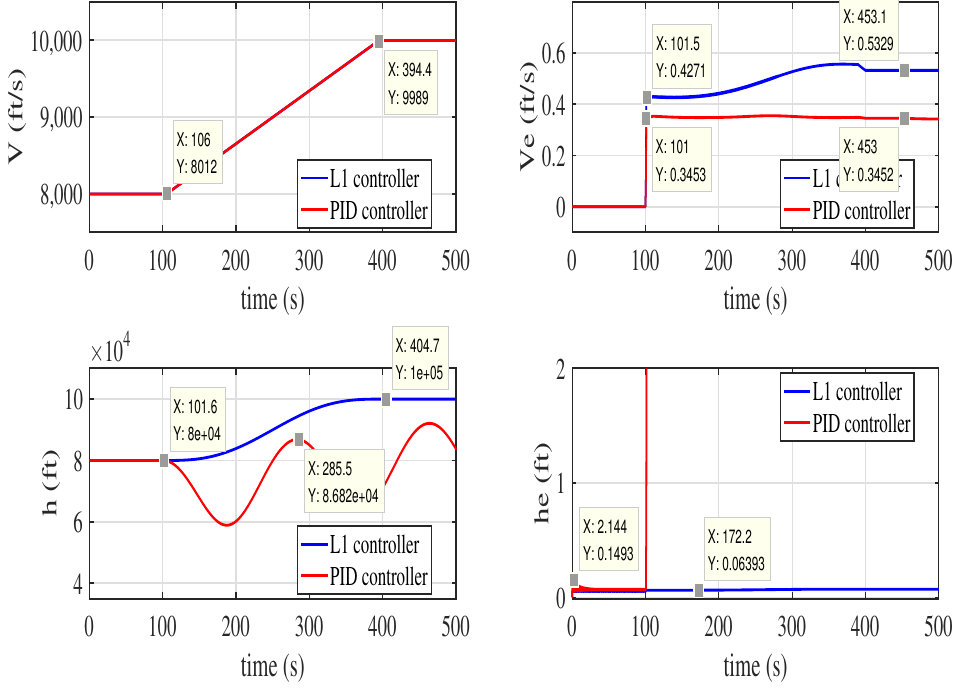
Figure 11. Comparison of velocity and velocity error, altitude and altitude error proposed by PID and L 1 controller in pitching maneuver and fault